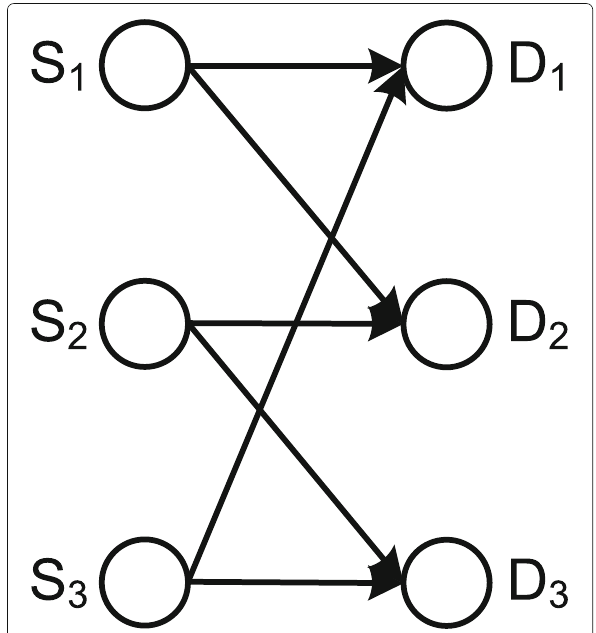
Fig. 8 The corresponding network G for the downlink cellular system illustrated in Fig. 7